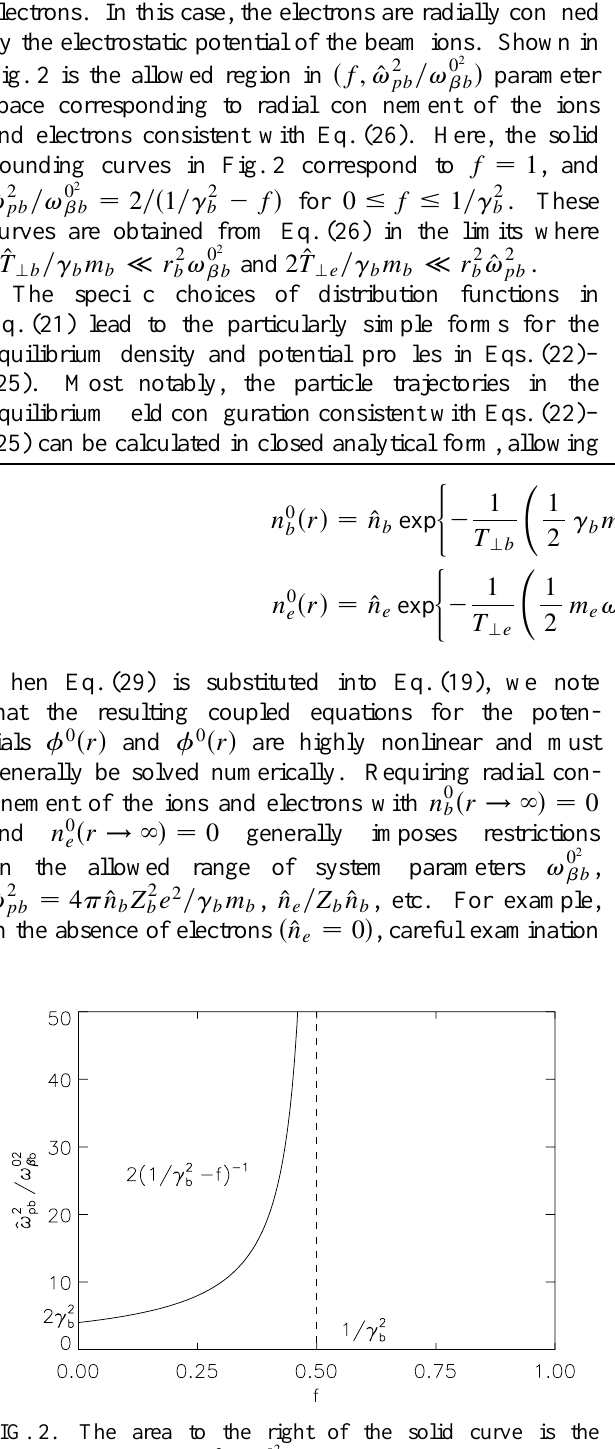
(cid:115) (cid:114) (cid:100)(cid:121) (cid:195) (cid:110) (cid:101) obtained (cid:101)